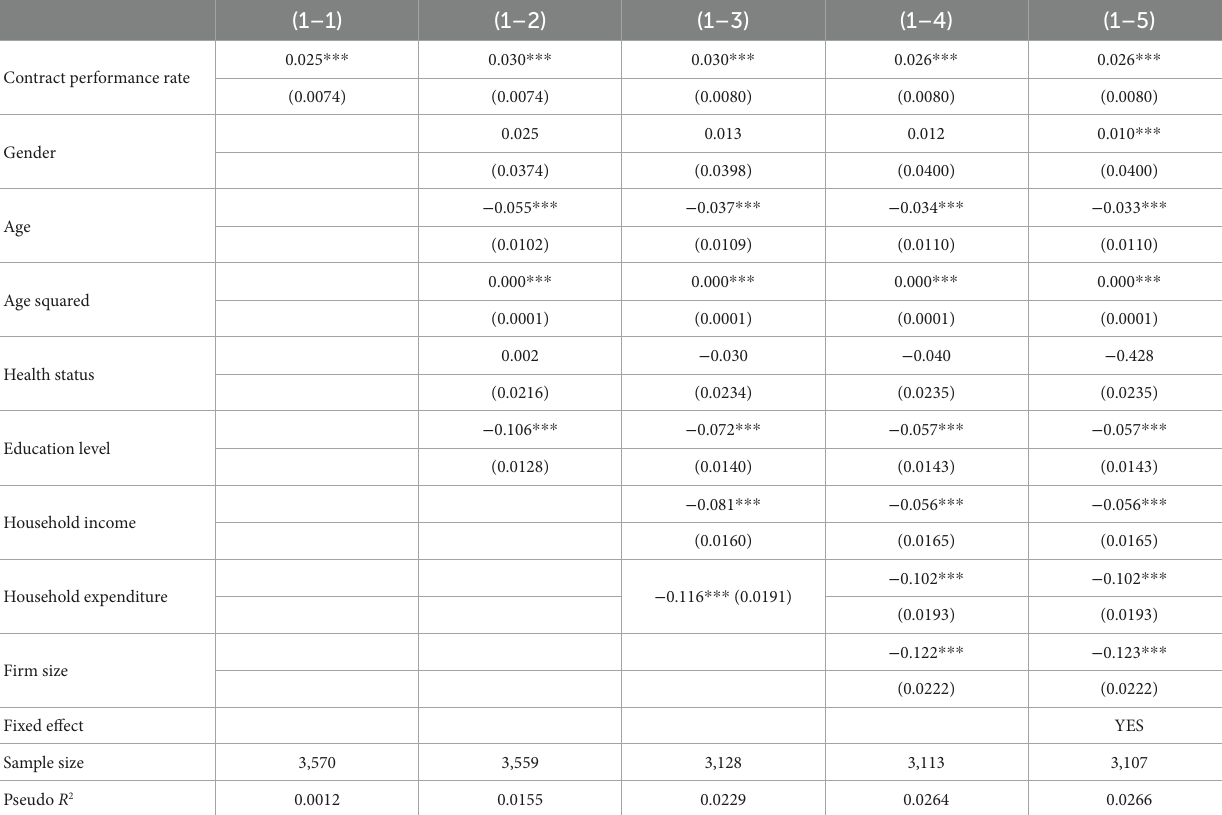
TABLE 4 Regression results of the direct effect analysis from the ordered probit